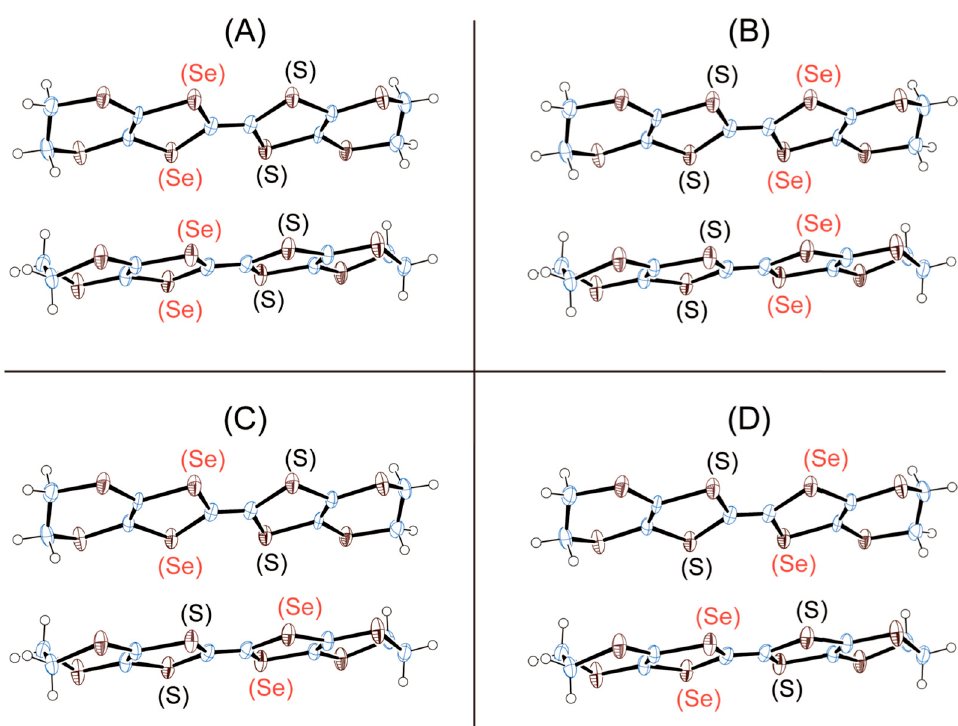
Figure 3. Four possible packing patterns ( A–D ) of the interacting pair of STF molecules at a given site in α -STF 2 I 3 . All four patterns should occur in the crystal with equal probability to reproduce the observed structure. Adapted from [21] and modified with permission.